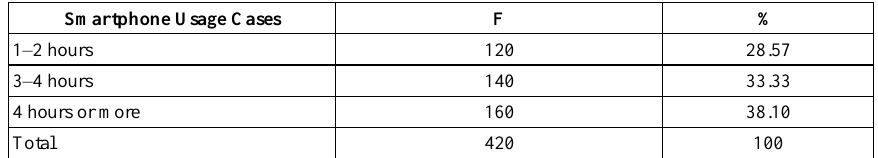
Table 4. Smartphone usage status of university students